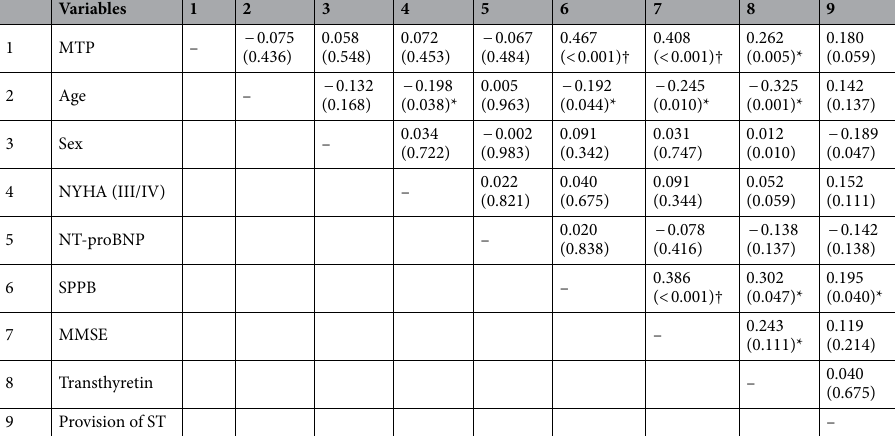
Table 2. Correlation matrix of Spearman rank-order correlation among variables in crude model. Values are correlation coefficient and ( P value). MMSE Mini-mental state examination, MTP Maximum tongue pressure,